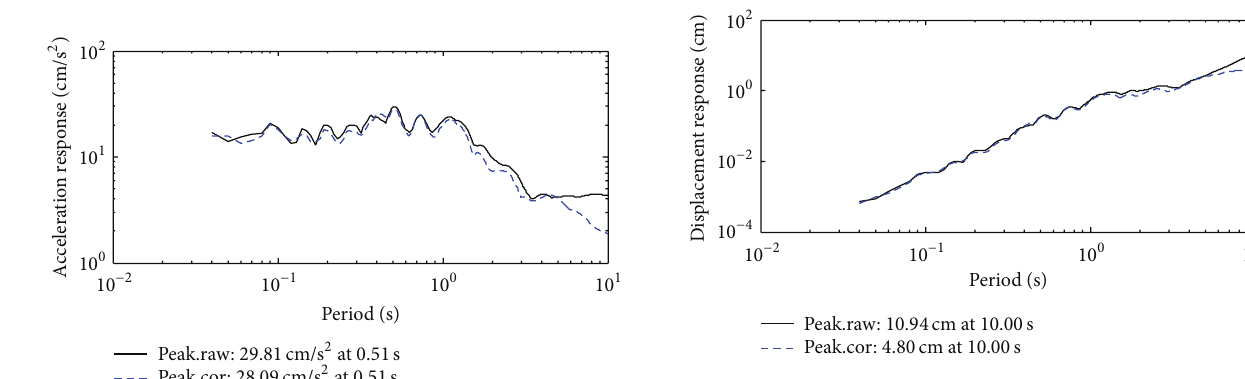
Figure 23: Relative displacement response